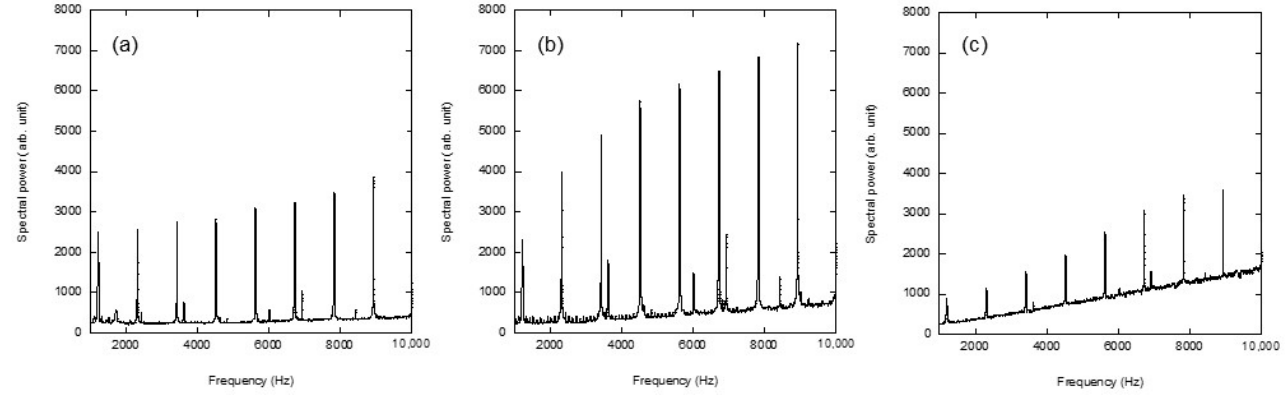
Figure 5. Laser-induced vibrational spectra of agarose with different Young’s moduli of ( a ) 0.042 MPa, ( b ) 0.76 MPa, and ( c ) 2.3 MPa.